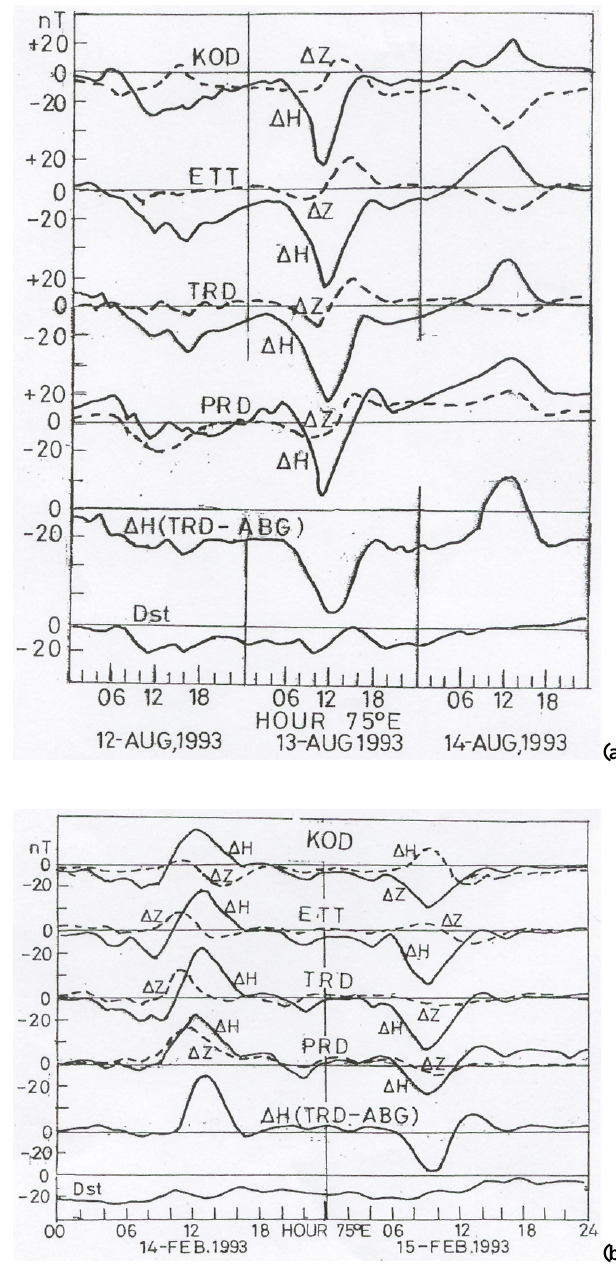
Fig. 7. Daily variations of 1H and 1Z at PRD, TRD, ETT and KOD as well as 1H (TRD–ABG) on normal and counter electrojet